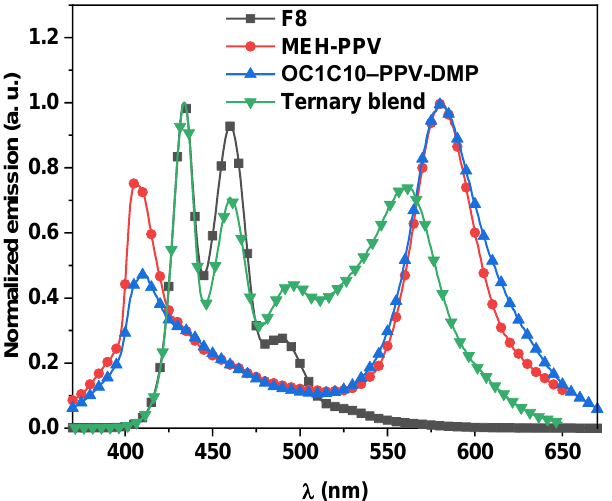
Figure 4. Normalized emission spectra of pristine F8, MEH-PPV, OC1C10-PPV-DMP, and their ternary hybrid.